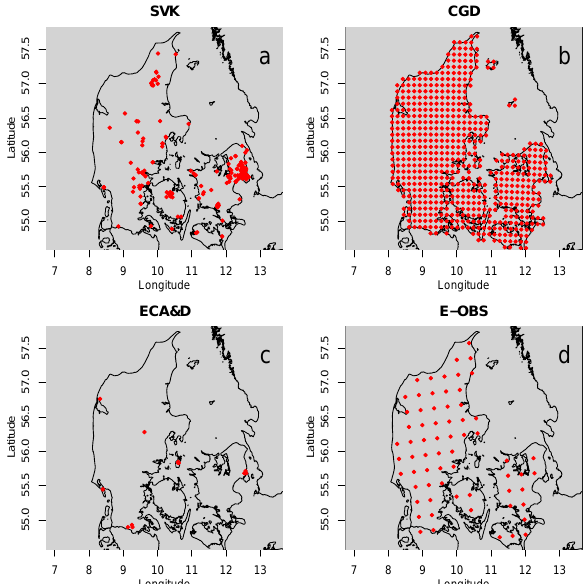
Fig. 1. Location of grid points and gauges of the observational data sets used. (a) Gauge locations of the Danish SVK gauge system, (b) grid locations of the regular 10km grid in the Climate Grid Den- mark (CGD), (c) gauge locations included in the ECA&D and (d) grid locations of the 25km rotated grid used by the E-OBS and the climate